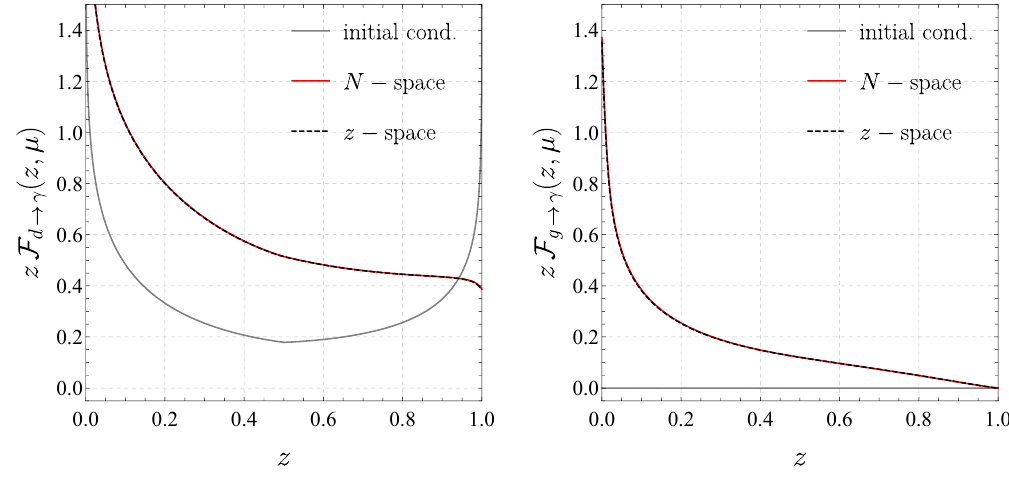
Figure 8 . Effect of RG-evolution on the cone fragmentation functions F i → γ . The gray lines shows the initial condition given by the LO fixed-order result at µ = 10 GeV and correspond to smooth-cone isolation with R = 0 . 4 with (cid:15) γ = 1 and n = 1 . The derivative of the initial condition is discontinuous at z = (1 + (cid:15) γ ) − 1 = 0 . 5 due to the contribution (3.10). The gluon fragmentation function vanishes at this order. The other lines are the results after evolution to µ = 200 GeV by solving the RG equations either in moment space (red lines) or in momentum space (dashed